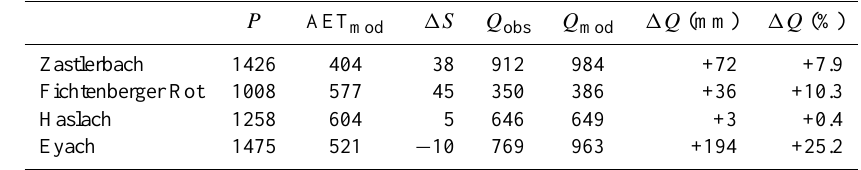
Table 7. Water budgets with absolute and relative discharge error ( 1Q ).